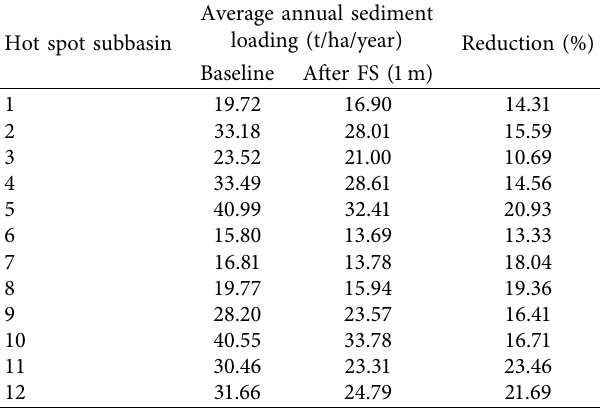
Figure 16: Comparison of sediment reduction by selected BMPs at critical subbasins. Table 13: Sediment reduction with filter strip